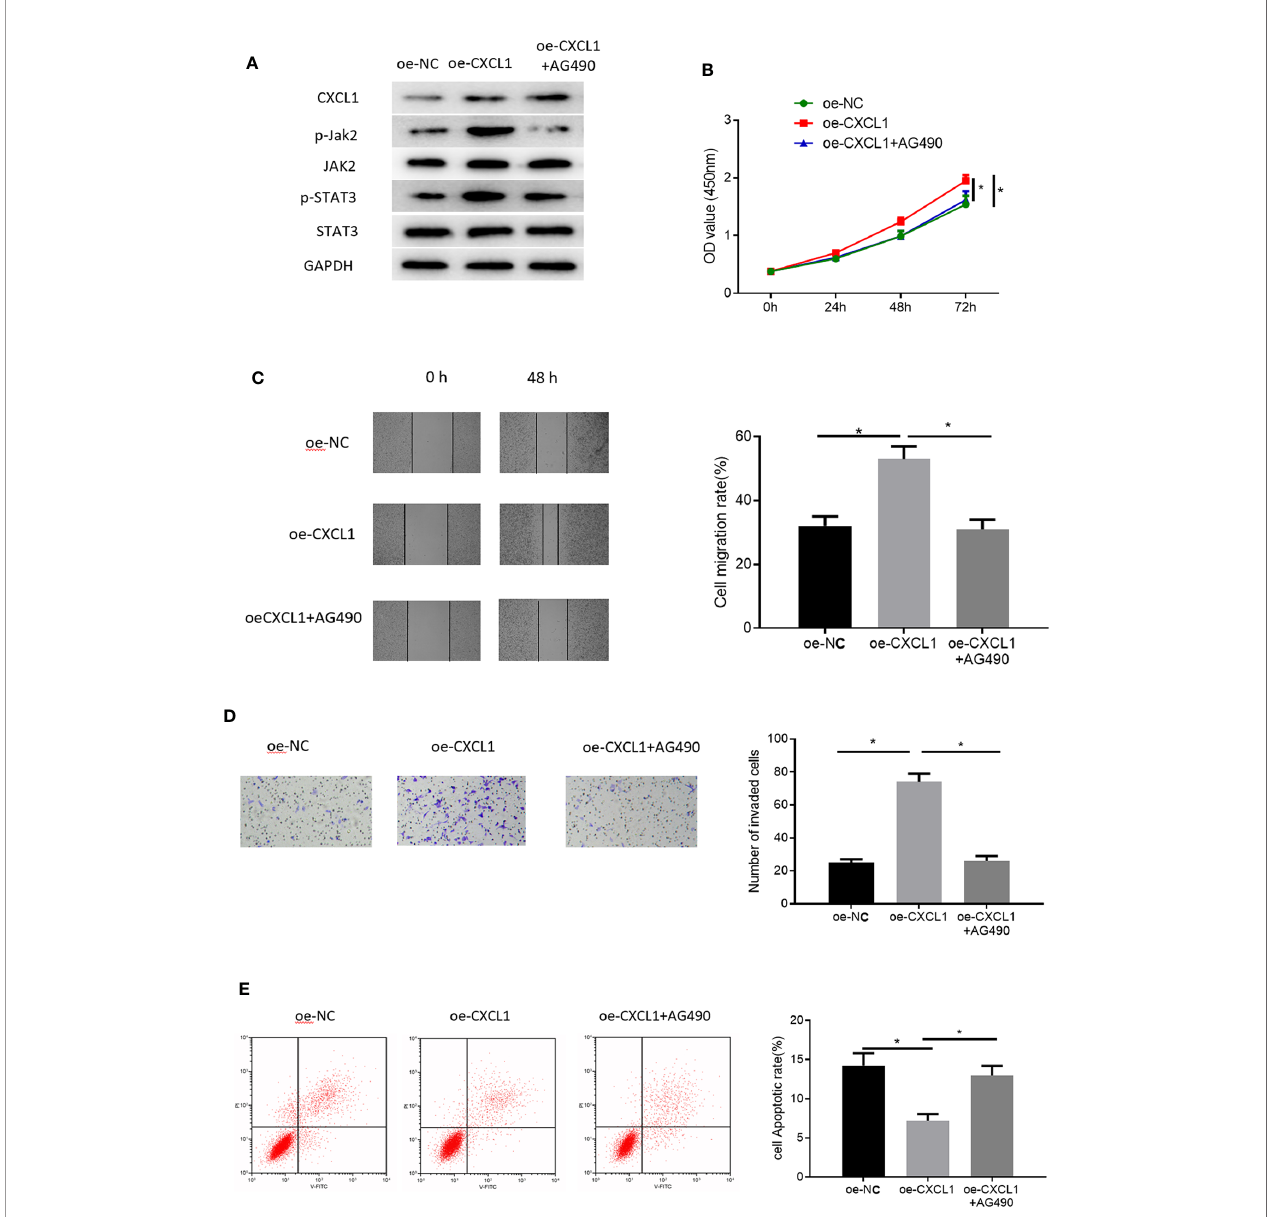
FIGURE 6 | CXCL1 activates JAK-STAT signaling pathway to promote cell proliferation, migration, invasion and inhibit cell apoptosis of CRC. Cells were divided into oe-NC, oe-CXCL1, and oe-CXCL1+AG490 groups. (A) Western blot showed the protein levels of CXCL1 in SW480 cells and the levels of the key proteins involved in JAK-STAT signaling way (p-Jak1, Jak2, p-STAT3, and STAT3), (B) CCK-8, (C) wound healing assay, (D) Transwell invasion assay (100×), and (E) fl ow cytometry showed the proliferation, migration, invasion and apoptosis of SW480 cells in each group (* p <